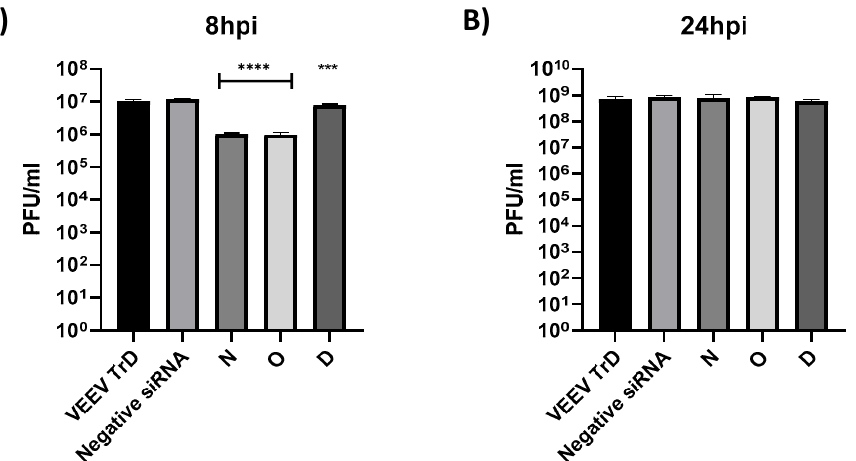
Figure 3. Antiviral activity of selected anti-VEEV siRNA against VEEV-TrD. ( A , B ) 293T cells were transfected with 20 nM individual VEEV specific siRNAs 24 h prior to infection. Transfected cells were then infected with VEEV TrD at an MOI of 0.1 and supernatants were collected at 8 hpi ( A ) and 24 hpi ( B ). Viral titers were determined via plaque assay. Graphs are representative of one independent experiment ( n = 3). *** p < 0.0002, **** p < 0.0001 compared to negative control